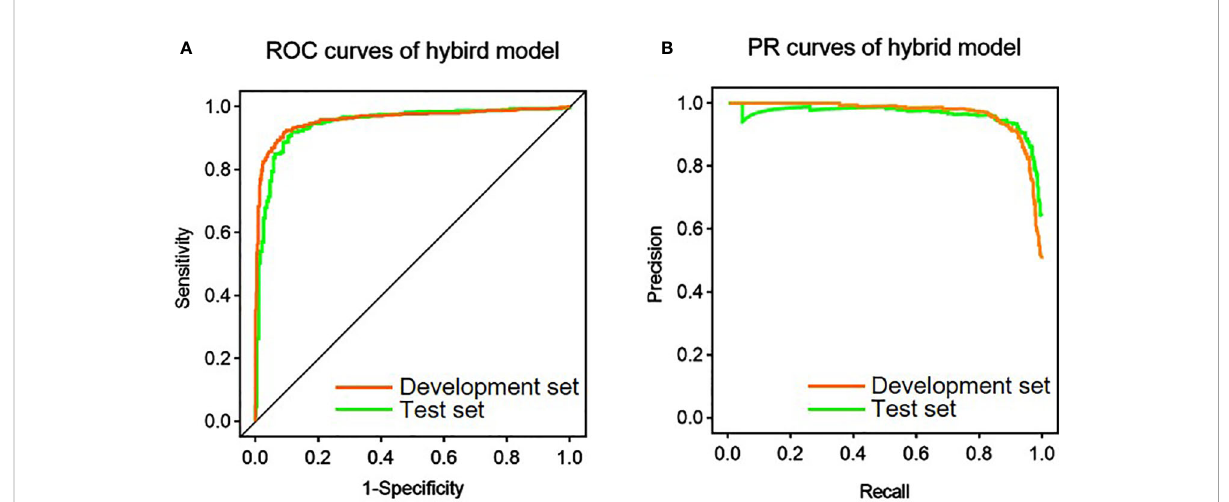
FIGURE 3 Performance of the hybrid model in the prediction of mitotic index. (A) Receiver operating characteristic (ROC) curves of the hybrid model in the development and test set. (B) Precision-recall (PR) curves of the hybrid model in the development and test